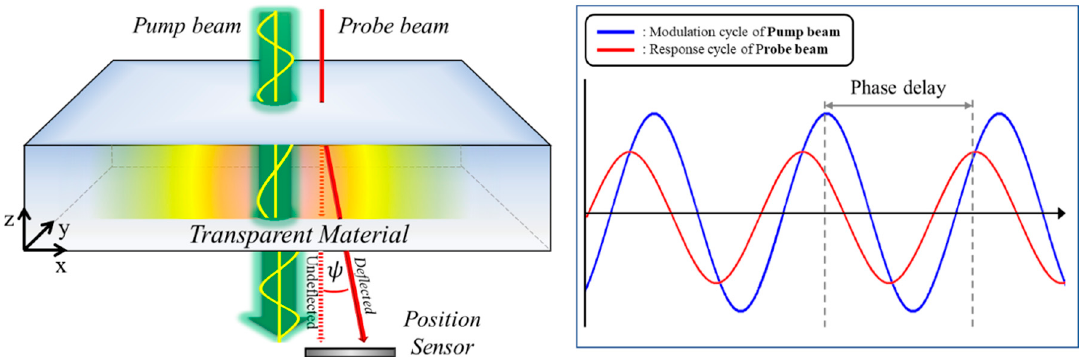
Figure 2. Schematic of phase delay.